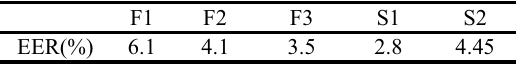
Tab. 2. EER of each simple recognition systems